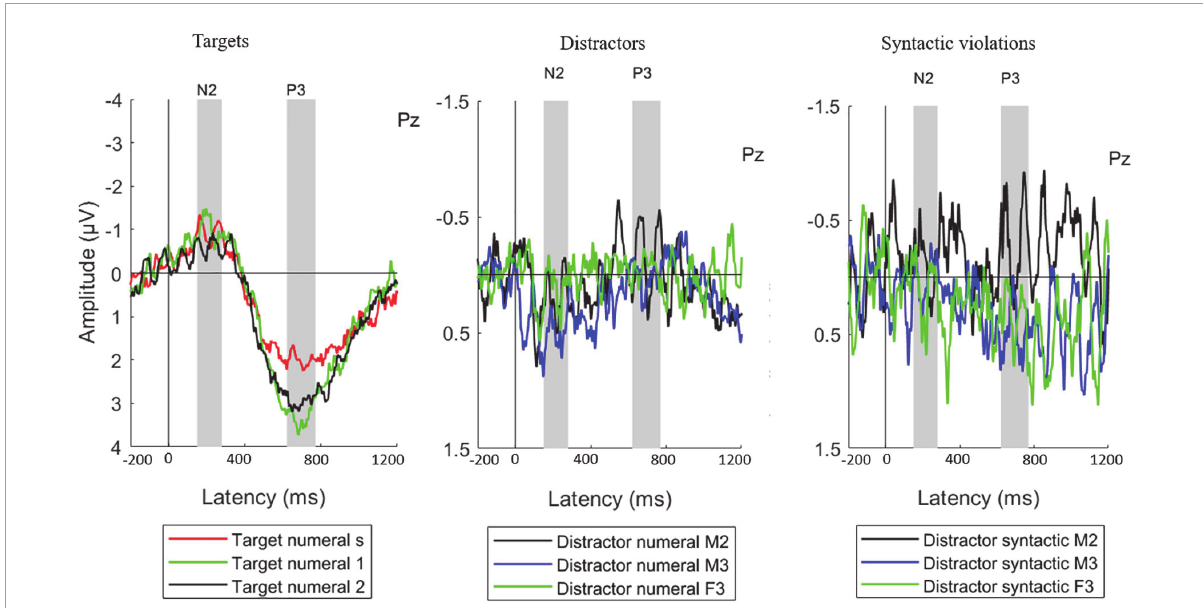
FIGURE2 Group average ( N = 23) ERP responses measured from the parietal (Pz) electrode position, separately for the target numerals (left) , distractor numerals (middle) , and distractor syntactic violations (right) . The measurement time windows for N2 and P3 are marked by gray vertical bands. Legend abbreviations for the target numerals: s – single-speech condition, 1 – one-distractor condition, 2 – two-distractor condition. Legend abbreviations for the distractor numerals and syntactic violations: M2 – male speaker in the one-distractor condition, M3 – male speaker in the two-distractor condition, F3 – female speaker in the two-distractor condition. Note the different scales for target and distractor